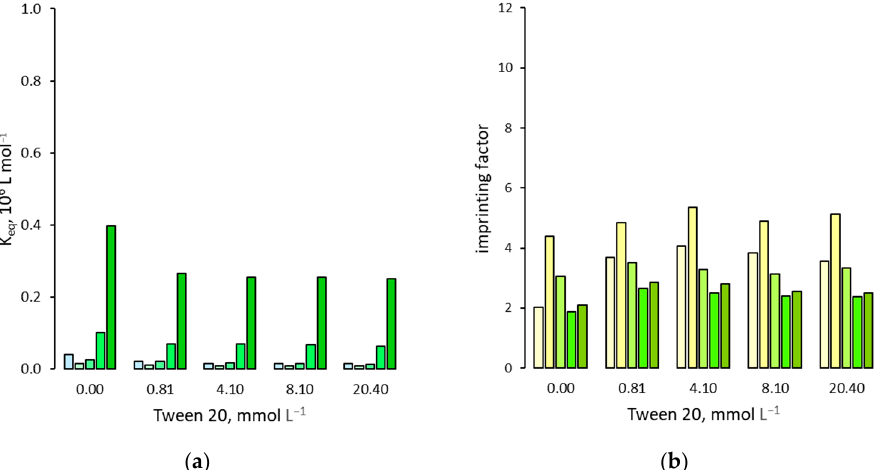
Figure 4. ( a ) Binding affinity of 2,4,5-T for the NIP in presence of increasing amounts of Tween 20; ( b ) Imprinting factor. For each group of bars from left to right: water molar fraction from 0 (pure acetonitrile) to 0.24, 0.42, 0.66 and 0.81.